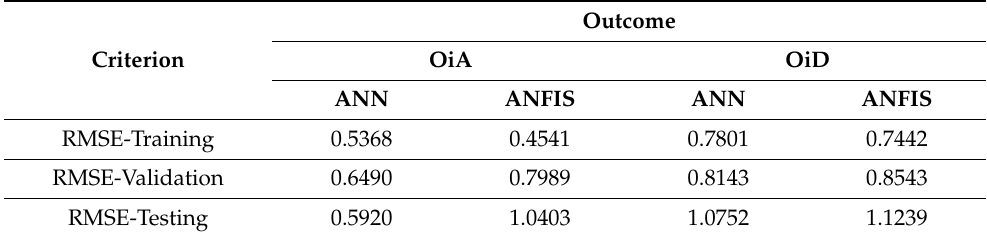
Table 9. Performance results of the ANN and ANFIS